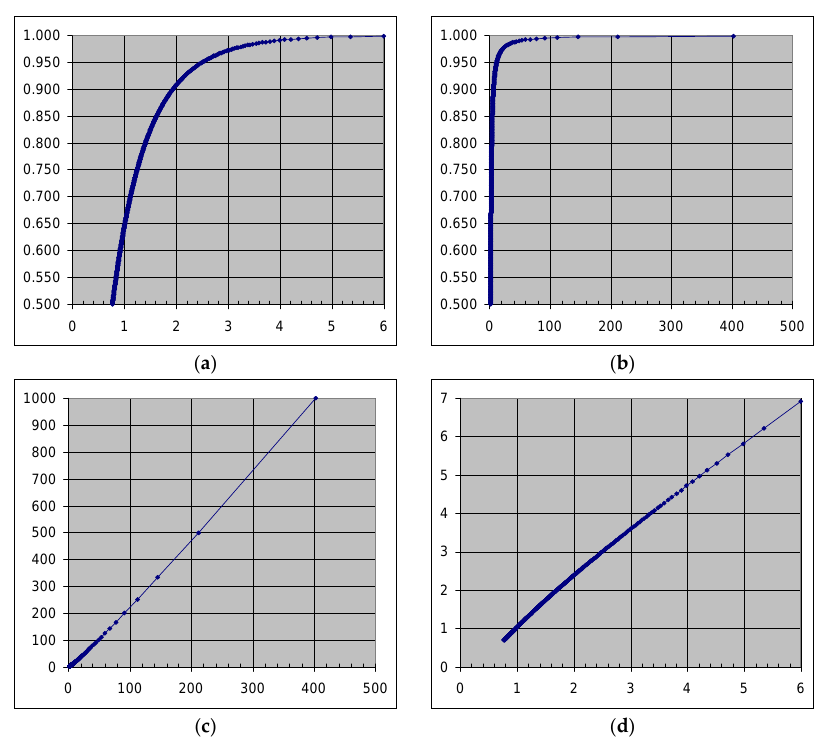
Figure 1. Probability as function of the AD statistic for a selected case ( n = 25) in the Monte Carlo experiment: ( a ) p = p (AD); ( b ) p = p (e AD ); ( c ) α‐ 1 vs. eAD; ( d ) − ln( α ) vs. AD. Table 6. Proposed model tested for the AD = AD( p ) series for n = 25. SST: Sum of Squares: Total; SSRes: Sum of Squares: Residuals; SSE = Sum of Squares Error.